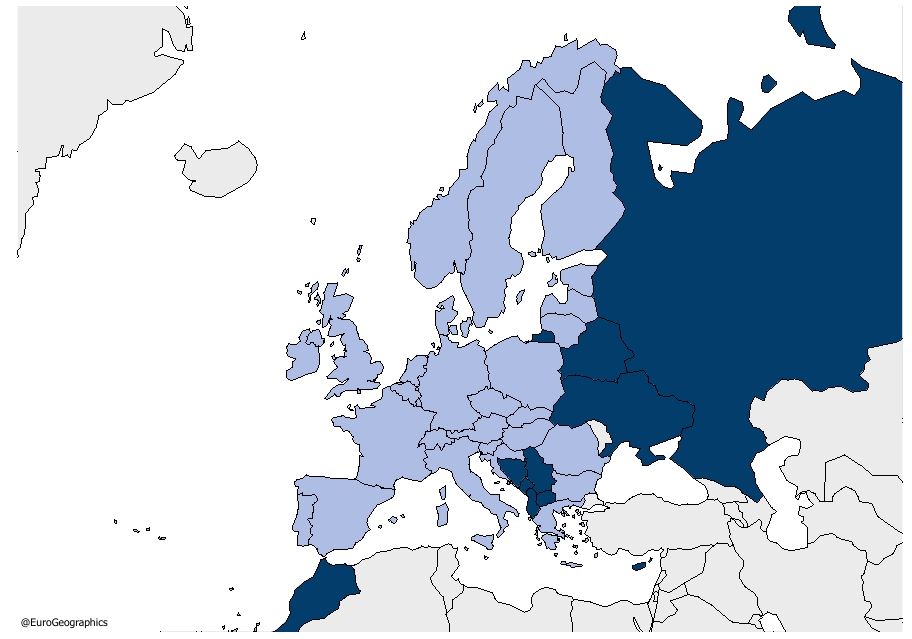
Figure 1. Map of the modeled regions, core (light blue) and outer (deep blue) regions. On the map the core regions are coloured light blue whereas the outer regions are coloured deep blue. Countries not modeled are shown in grey.